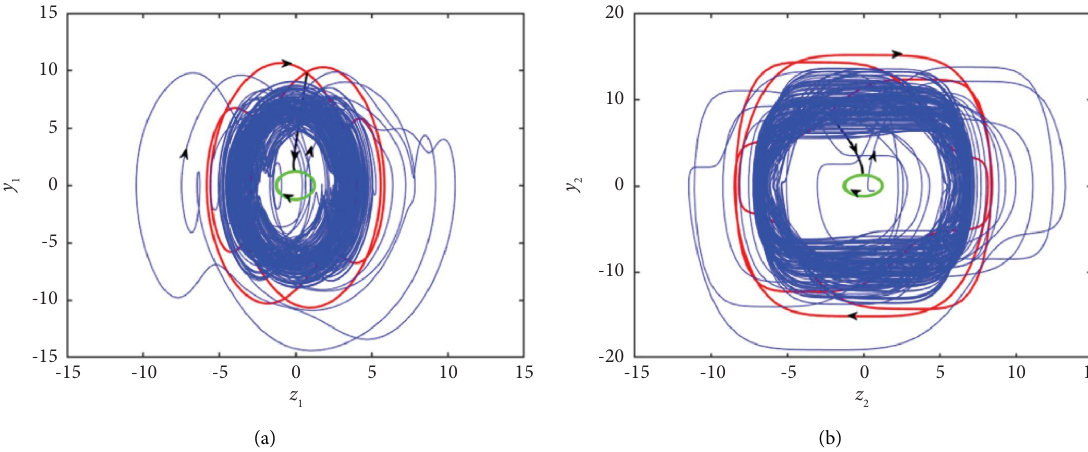
Figure 13: Te phase trajectories of the system responses under the OLPNCL control. (a) Te mechanical equipment response phase trajectory. (b) Te NES response phase